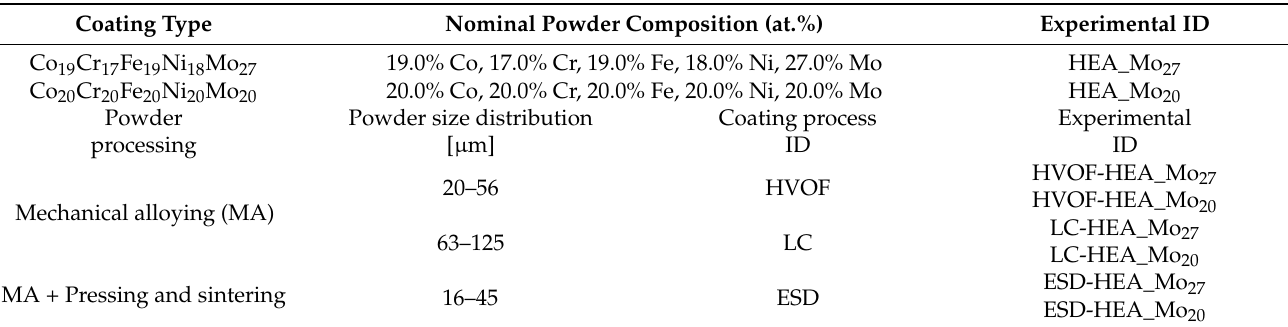
Table 1. Summary table of the powder composition, properties and techniques used for the different deposition techniques.